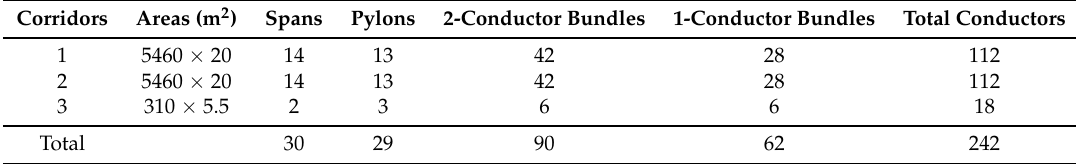
Figure 8. 3D view of spans from Bindebango and Maindample sites. Table 1. Summary of Maindample (MDP) data